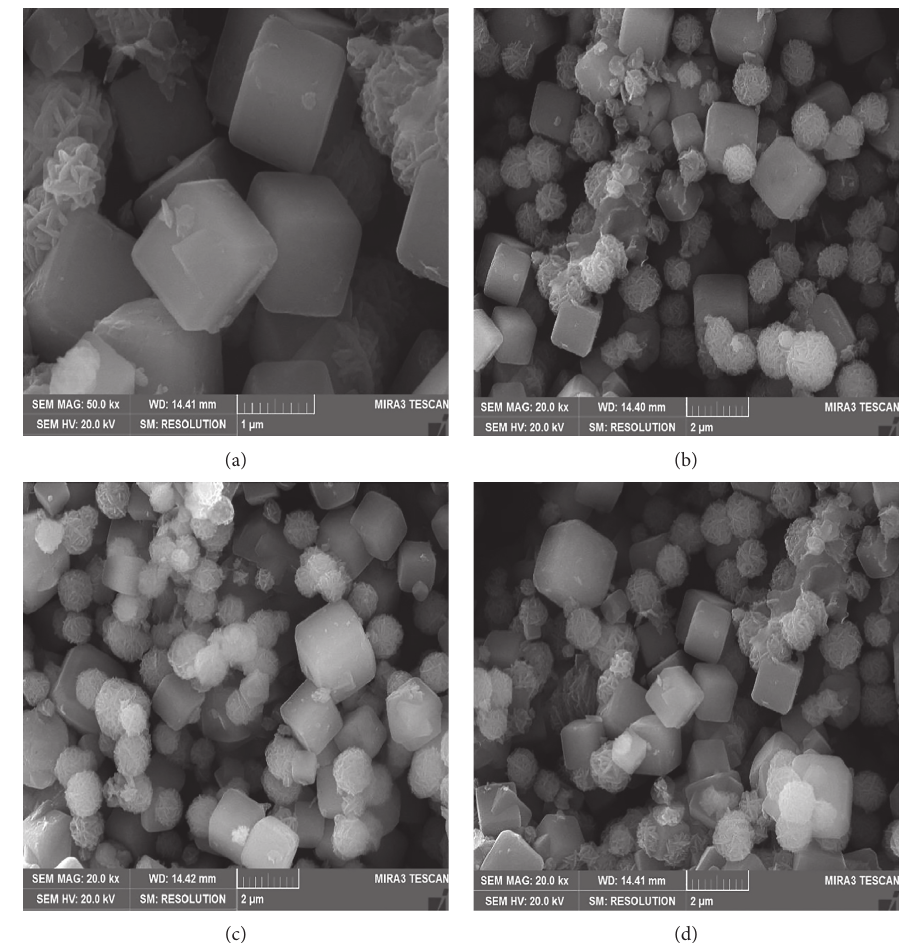
Figure 7: SEM pictures of EMRZ synthesized under various initial Si/Al ratios: (a) 1.5; (b) 2.0; (c) 2.5; (d) 3.0 (synthesis conditions: reaction temperature, 100 ° C; reaction time,